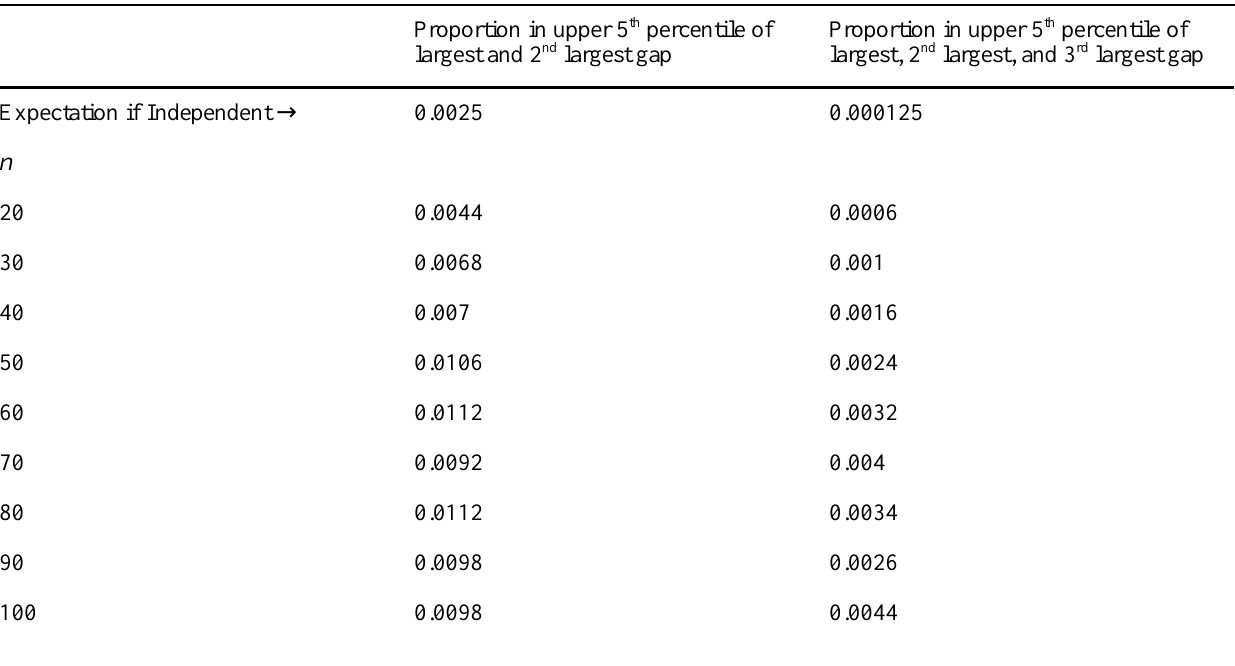
Table 1. Comparison of the joint probability of the largest and second largest gaps, and the largest, second largest, and third largest gaps all simultaneously falling in the upper 5 th percentile of their respective marginal distributions. Results are based on 5000 random draws from uniform distributions for assemblages ranging from n = 20 to n = 100